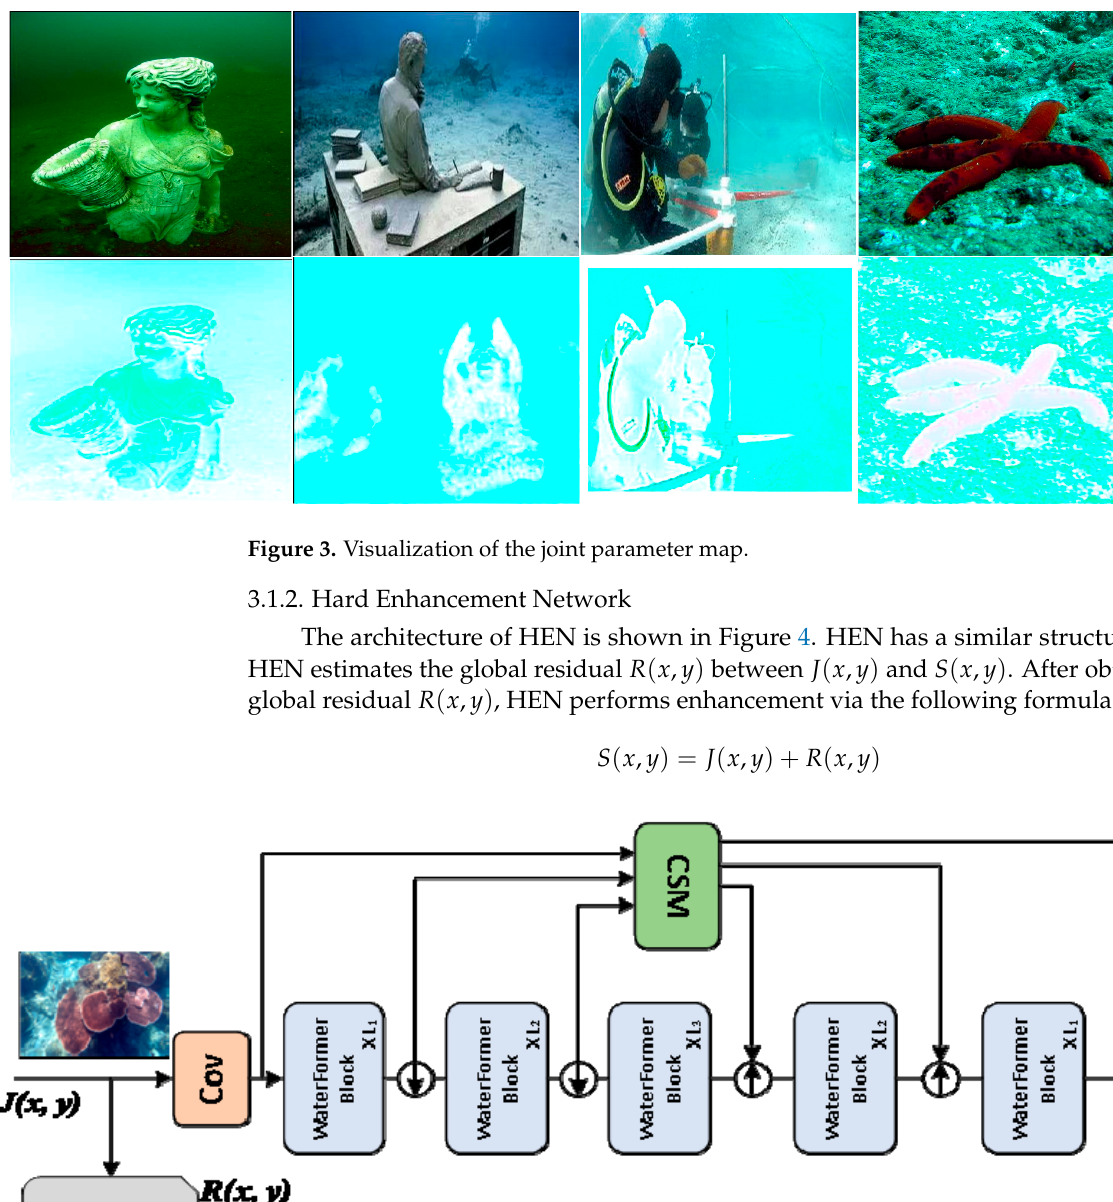
Figure 4. The overall structure of HEN.